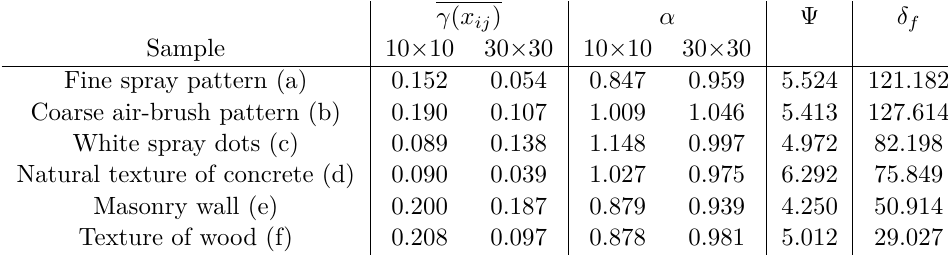
Table 1. Mean correlation coefficient, γ ( x ij ), power law distribution decay parameter α , Ψ, and δ f for tested patterns / textures and different size of subsets.